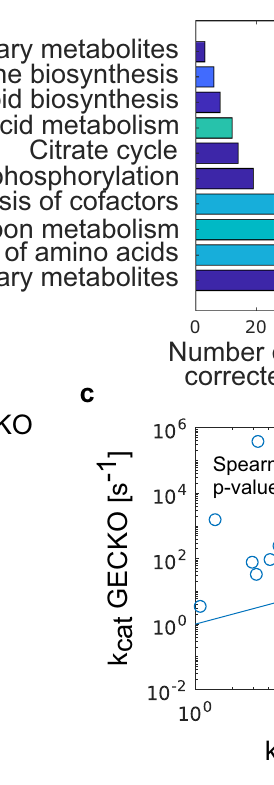
Fig. 3 | Comparison of enzymes with corrected k cat values by both GECKO and PRESTO. a KEGG Pathway terms signi fi cantly enriched in the set of enzymes cor- rectedbyPRESTO ð λ =10 (cid:1) 7 Þ inthe S.cerevisiae pcGEM.The x -axisgivesthenumber of corrected enzymes linked to the given term. The one-sided p -values were cal- culated using the hypergeometric density distribution and corrected for multiple hypothesis testing using the Benjamini – Hochberg procedure 45 . b Venn diagram